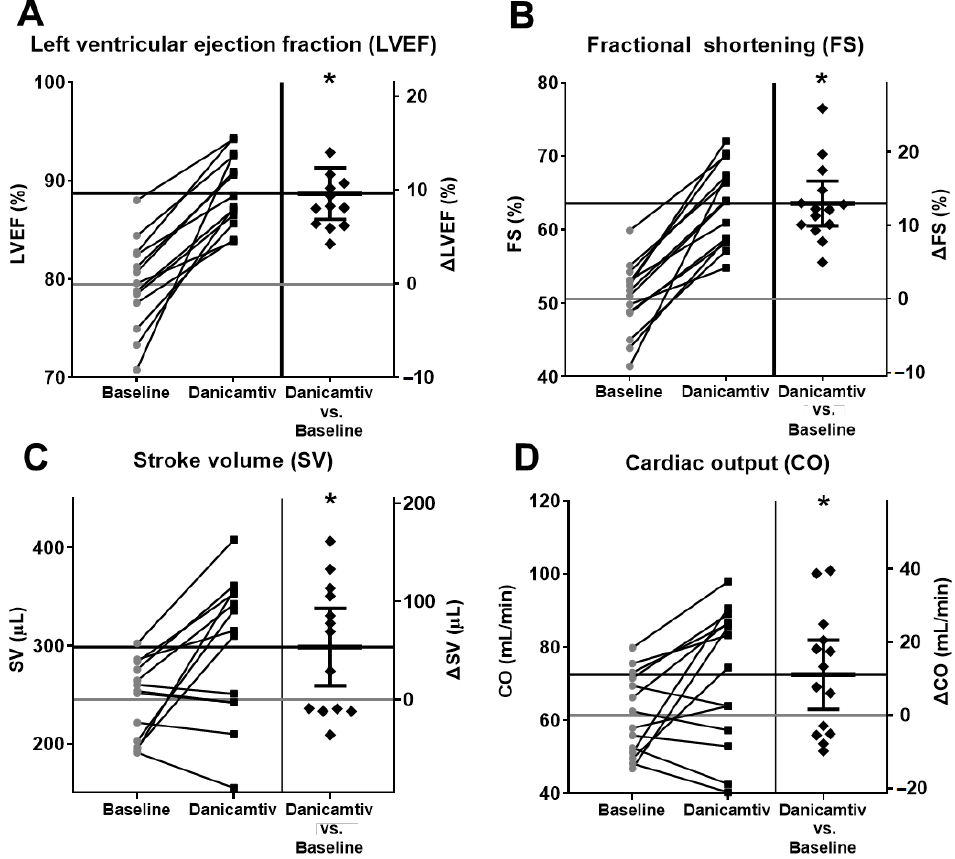
Figure 2. Danicamtiv augmented left ventricular systolic function. Danicamtiv improved LV systolic contractile parameters: LV ejection fraction (EF) ( A ), fractional shortening (FS) ( B ), and stroke volume (SV) ( C ). Cardiac output also increased upon danicamtiv administration ( D ). (The construction of panels is identical with those in Figure 1C – D). * = p < 0.05 .